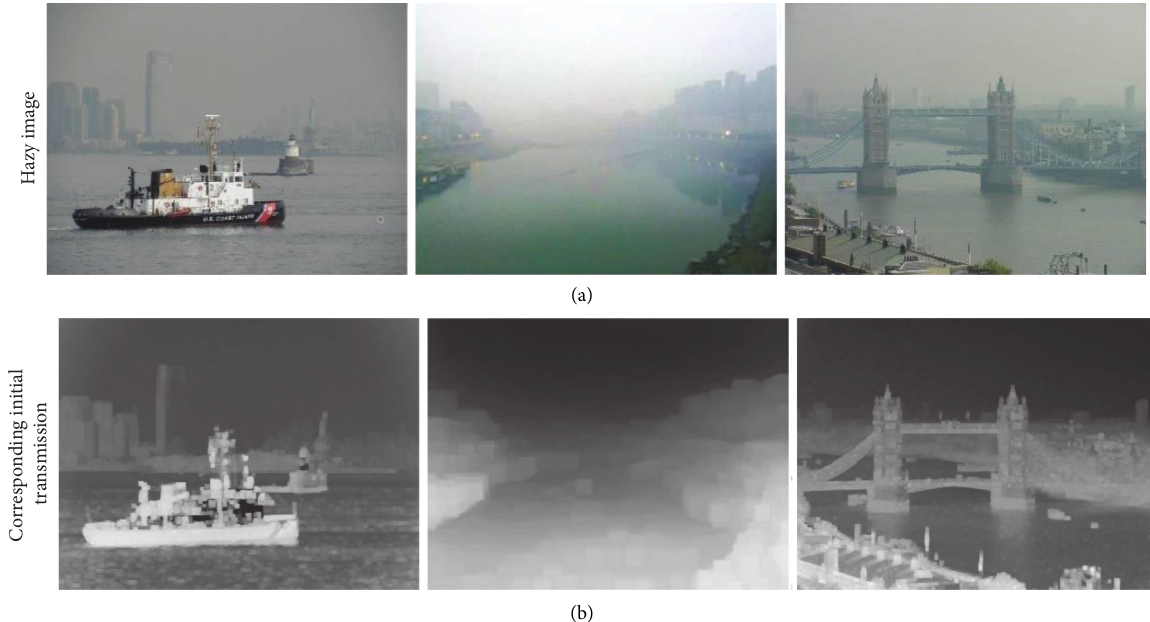
Figure 1: The hazy image on the water with sky region (a) and the corresponding initial transmission